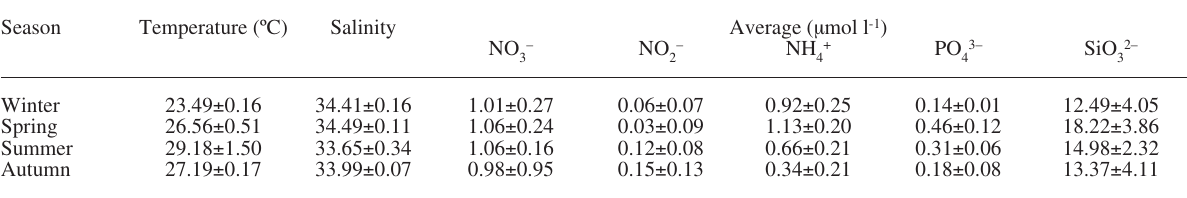
Table 1. – statistical data (means ± std. deviation) of some environmental factors of sanya Bay from 2003 to